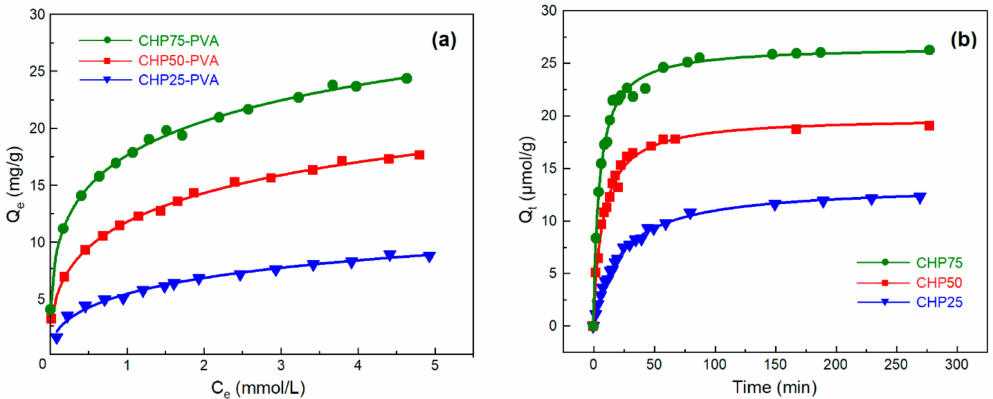
Figure 5. Equilibrium dye uptake of methylene blue by PANI-based composite materials at 298 K and pH 7: ( a ) equilibrium isotherm according to the Sips model in their film form; ( b ) kinetic profiles fitted to the pseudo-second order (PSO) model for the powdered